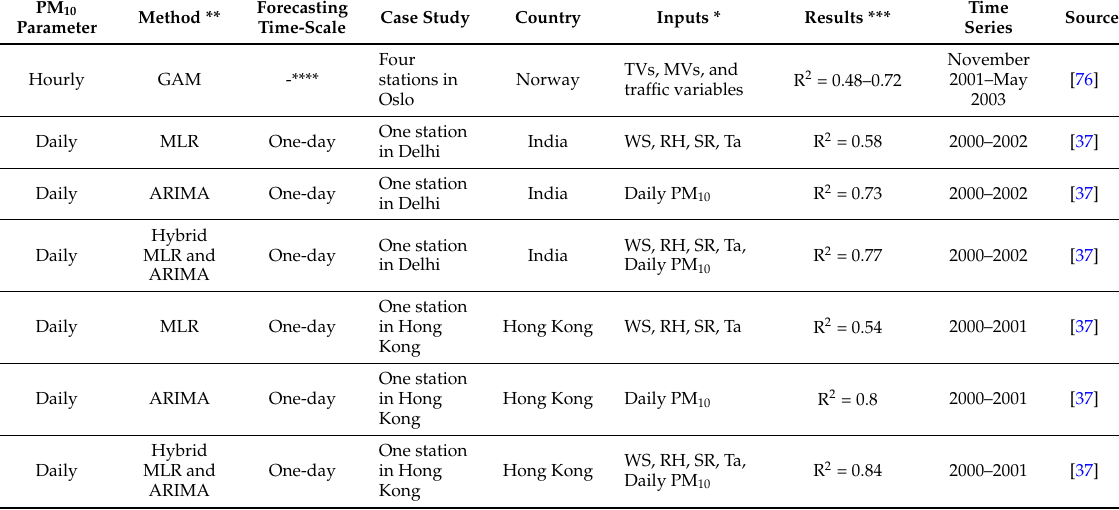
Table 3. Results of the application of other techniques for PM 10 forecasting, and their comparison with MLR and ANN